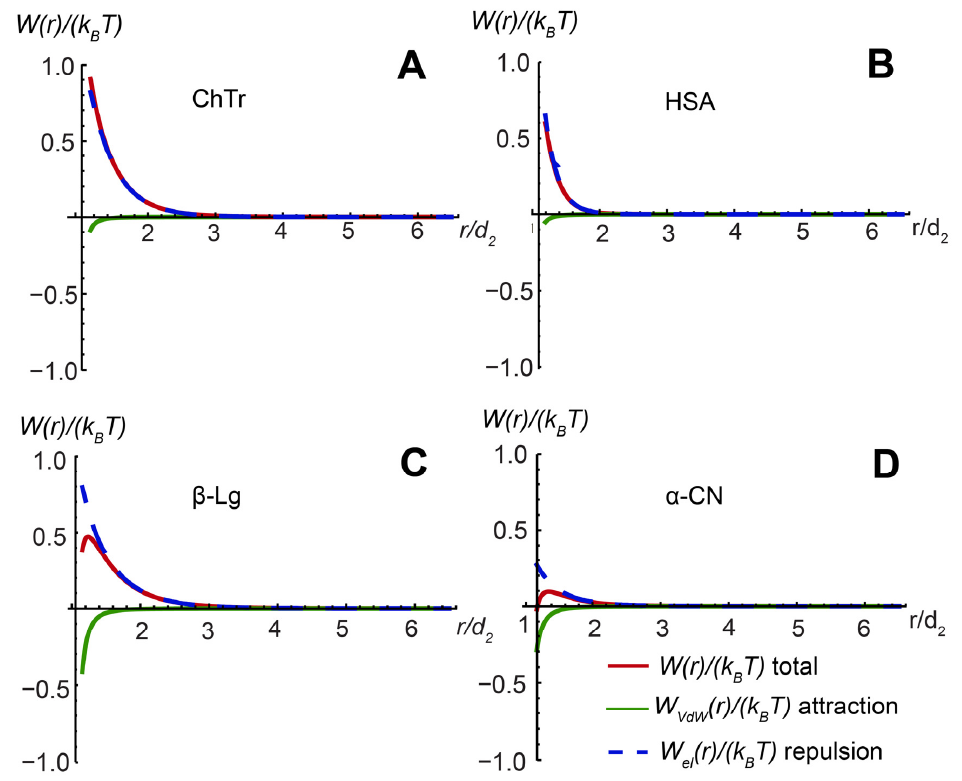
Figure 7. Total paired PPI potential and its constituent elements for ( A ) ChTr (pH = 3.5, I = 0.01 M); ( B ) has (pH = 7.2, I = 0.01 M); ( C ) β -Lg (pH = 7.0, I = 0.003 M); ( D ) α -CN (pH = 7.0, I = 0.01 M). The original data for ChTr ahasHSA were obtained from [51,120].